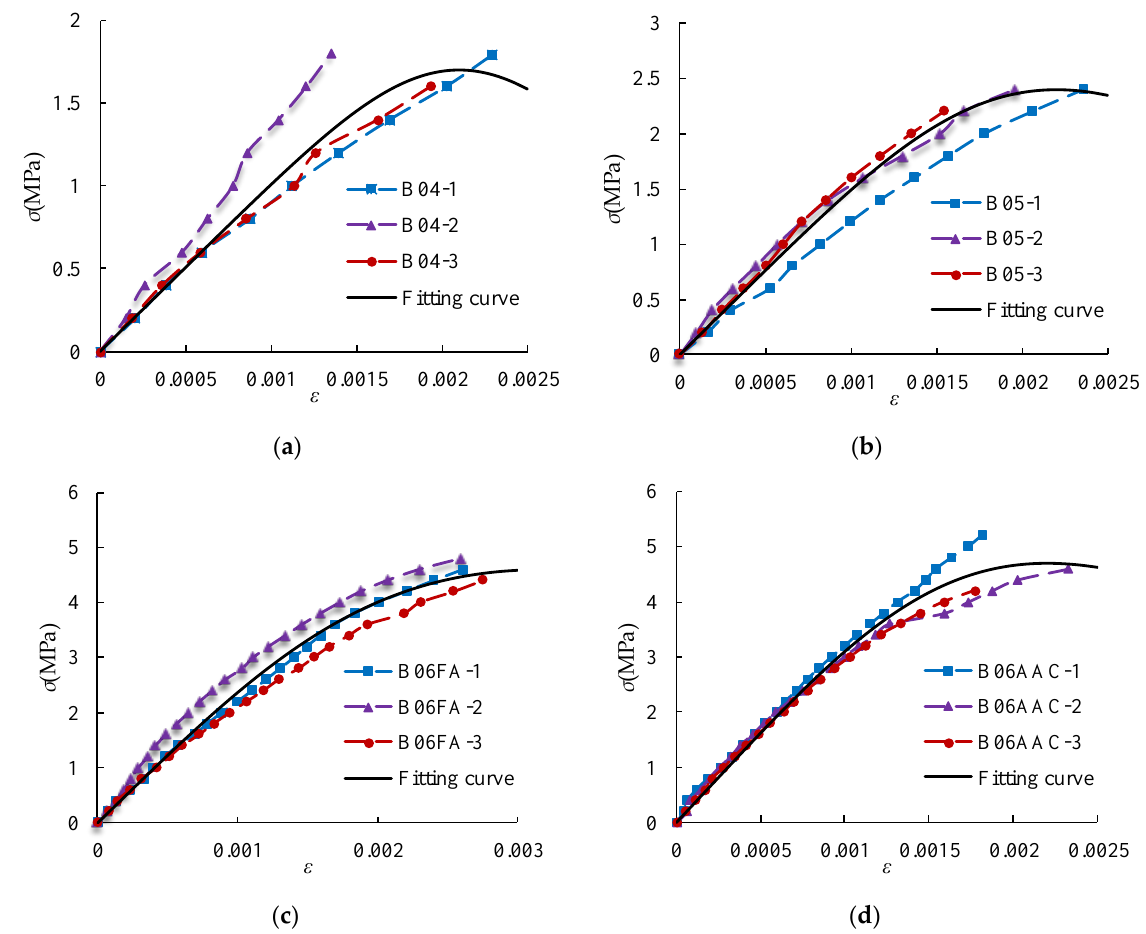
Figure 17. Stress–strain relationship and fitting curve of AAC: ( a ) B04; ( b ) B05; ( c ) B06FA; and ( d ) B06S.